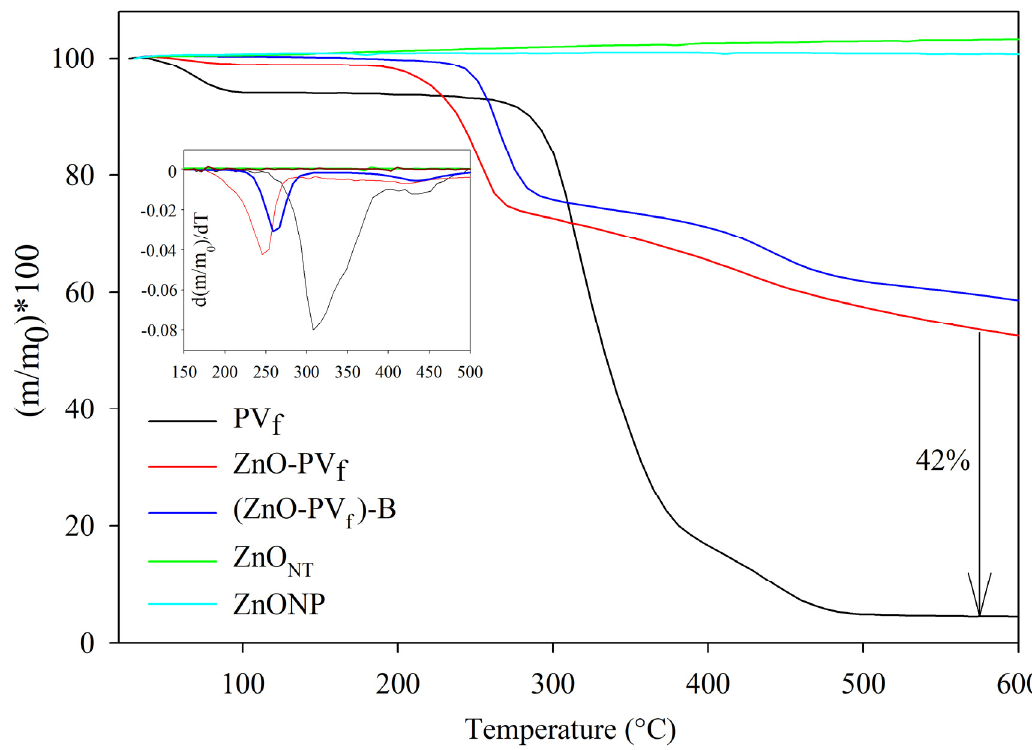
Figure 5. Weight loss with temperature of developed nanostructures (insert: derivative of weight loss with respect to temperature).